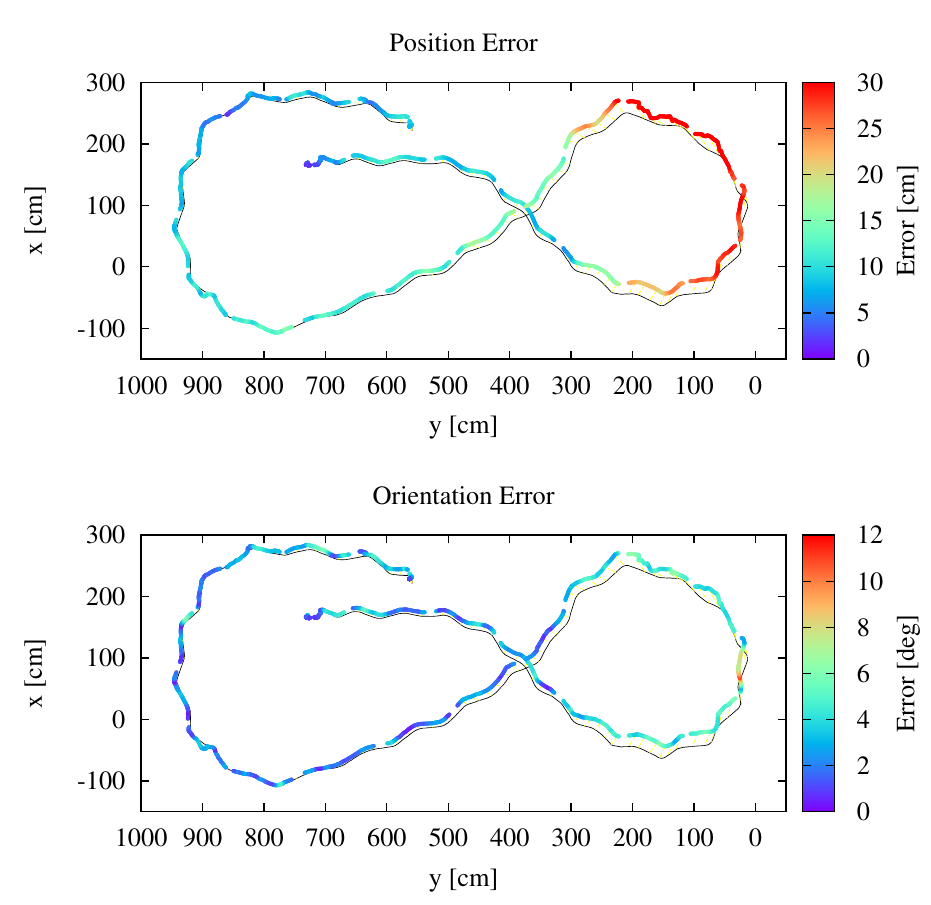
Figure 16. Experiment 1. Aligning trajectories without ICP. ( Top ): position error after applying semi-rigid registration. ( Bottom ): orientation